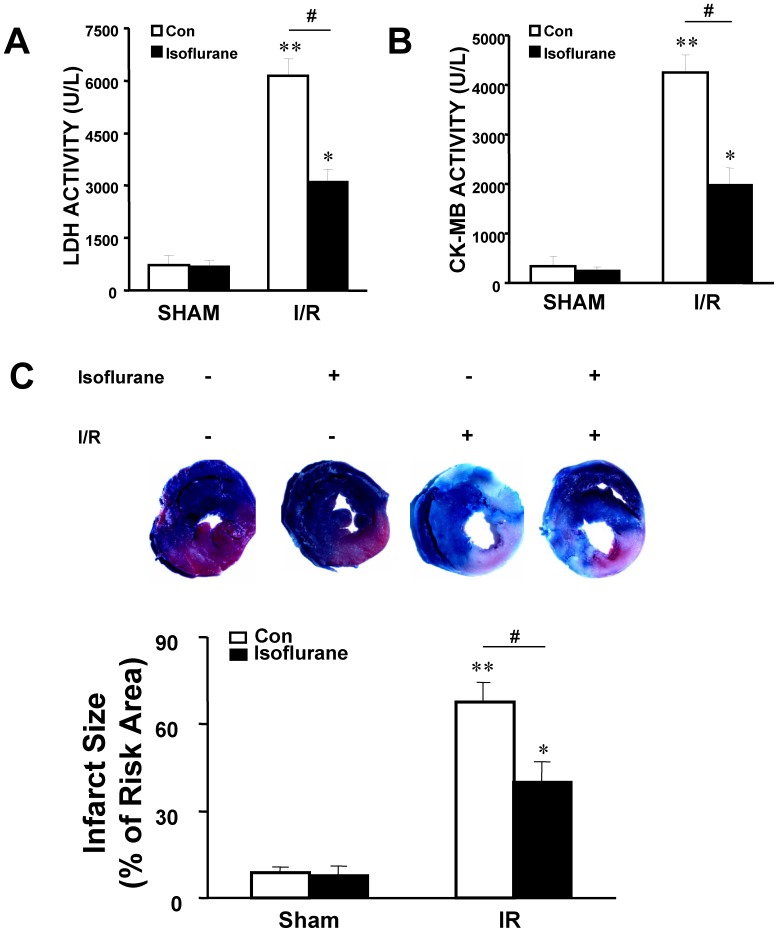
The influence of anesthetic-induced preconditioning with 1.0 MAC of isoflurane on leakage of LDH and CK-MB, and infarct area in rat hearts.A, B. Serum LDH and CK-MB concentrations were analyzed. The increase in LDH and CK-MB concentrations was lower in rats pretreated with isoflurane than in I/R group. C. Isoflurane preconditioning significantly decreased infarct area compared with I/R group animals. Representative cross-sectional slices derived from a single heart with and without isoflurane. The infarct size normalized to the area at risk. Values are means ± S.E.M., n = 5 in each group. *P<0.05, **P<0.01 vs. sham group, and #P<0.05 vs. the I/R control group.